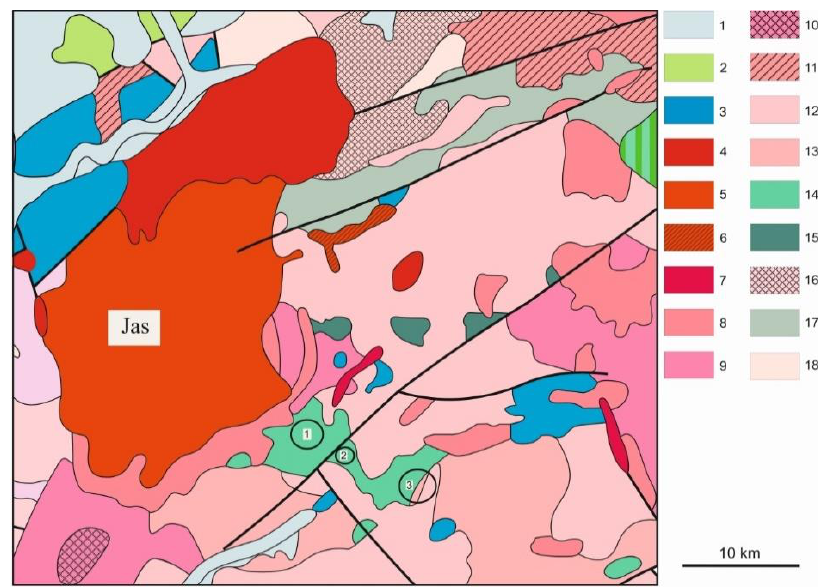
Figure 1. Schematic geologic map of the Darasun district and its vicinities [22]. (1) Quaternary; (2) Upper Turga subseries (K1tr2): sandstone, siltstone, mudstone, conglomerate, basaltic andesite, trachybasalt, rhyolite, tuff, tuffaceous rocks, and coal; (3) Nerchinsk poorly defined series (J3nr): latite, quartz latite, trachybasalt, trachyandesite, trachyrhyodacite, rhyolite, trachirhyolite, tuff, conglomerate, sandstone, siltstone, and tuffaceous rock; (4) Dotulur complex ( γ J3d): leucogranite, pegmatoid granite, and amazonite granite; (5–7) Amudzhikan–Sretensky complex (q ξ 2J3as): (5) phase-II quartz syenite, (6) phase-II granodiorite porphyry, (7) phase-II granite porphyry; (8–10) Amanan complex ( γ 2J2-3a): (8) phase-II granite ( γ ) and aplite-like granite, (9) phase I quartz syenite (q ξ J2-3a), (10) phase I granodiorite ( γδ 1J2-3a); (11) Bichura complex, phase III ( γ 3P2b): leucogranite, granite, porphyry